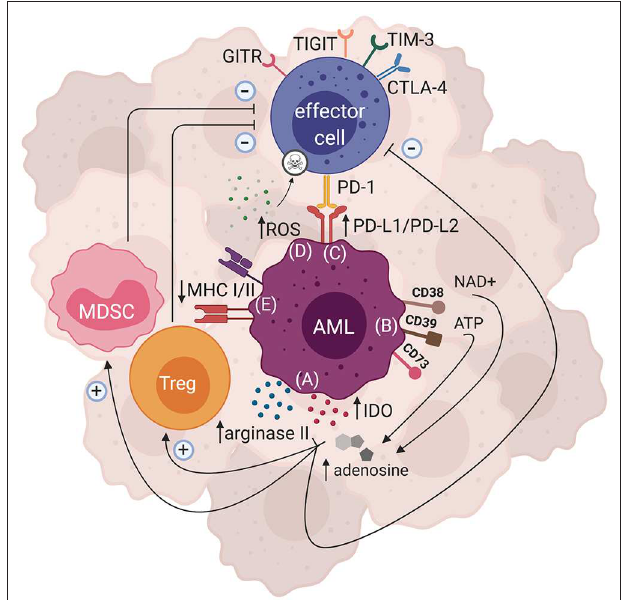
FIGURE 1 | Mechanisms of AML-induced immunosuppression. There are several immunosuppressive pathways that have been described for AML. Both direct and indirect mechanisms can ultimately lead to AML immune escape. (A) Enzymes such as arginase II and IDO can be expressed by AML blasts, leading to production of metabolites that hinder effector cell function and proliferation, while polarizing the tumor microenvironment to become more immunosuppressive by favoring Treg and MDSC expansion. (B) AML blasts can express ectonucleotideases such as CD38, CD39, and CD73 that are involved in the breakdown of ATP and NAD + to adenosine, which subsequently dampens effector cell function and enhances the activity of immunosuppressive cells. (C) Inhibitory ligands such as PD-L1 and PD-L2 can be expressed by AML blasts, and upon binding with their cognate PD-1 receptor may lead to effector cell suppression. Expression of other inhibitory receptors such as GITR, TIGIT, TIM-3, and CTLA-4 have also been shown in AML. (D) AML blasts are able to produce large amounts of ROS that subsequently trigger apoptosis of effector cells. (E) AML blasts can also downregulate their MHCI and/or MHCII expression, thus impairing their antigen presentation resulting in immune